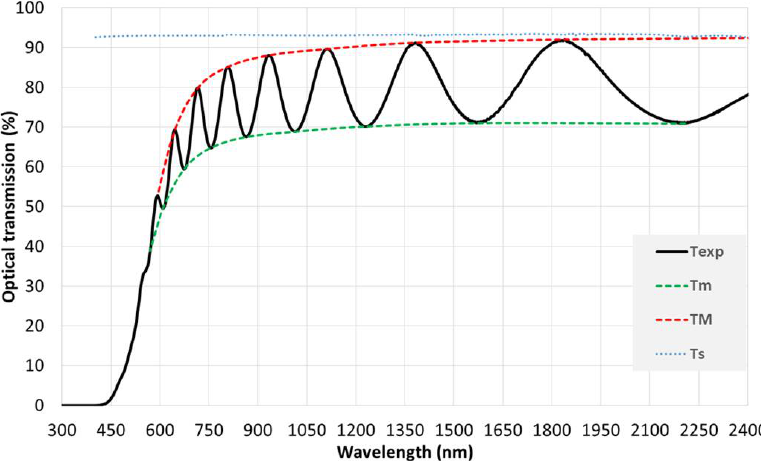
Figure 5. Typical transmission spectrum for the as-deposited garnet sample; where T exp is the measured transmission of the sample, T M and T m are the maxima and minima of the envelopes. Transmission spectrum of 1 mm thick glass substrate is also included in the figure.